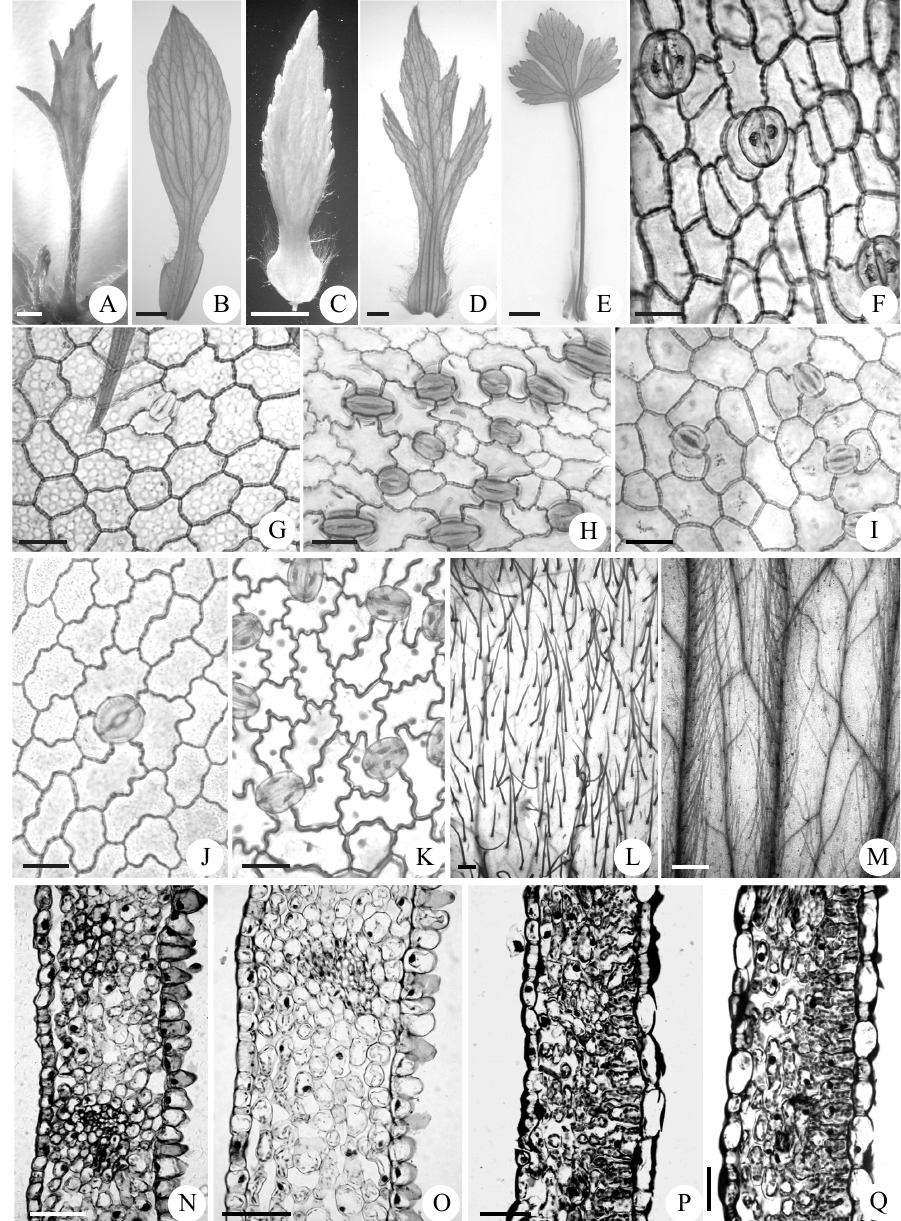
Figure 4. The metamorphic stamens and their microscopic characteristics of Anemone barbulata . ( A – E ) Five types of leaflike stamens, showing a 3-lobed edge and a long stalk ( A ), an entire edge and a broad stalk ( B ), a dentate edge and broad stalk ( C ), 3–4 shallow lobes ( D ), and three deep lobes ( E ),